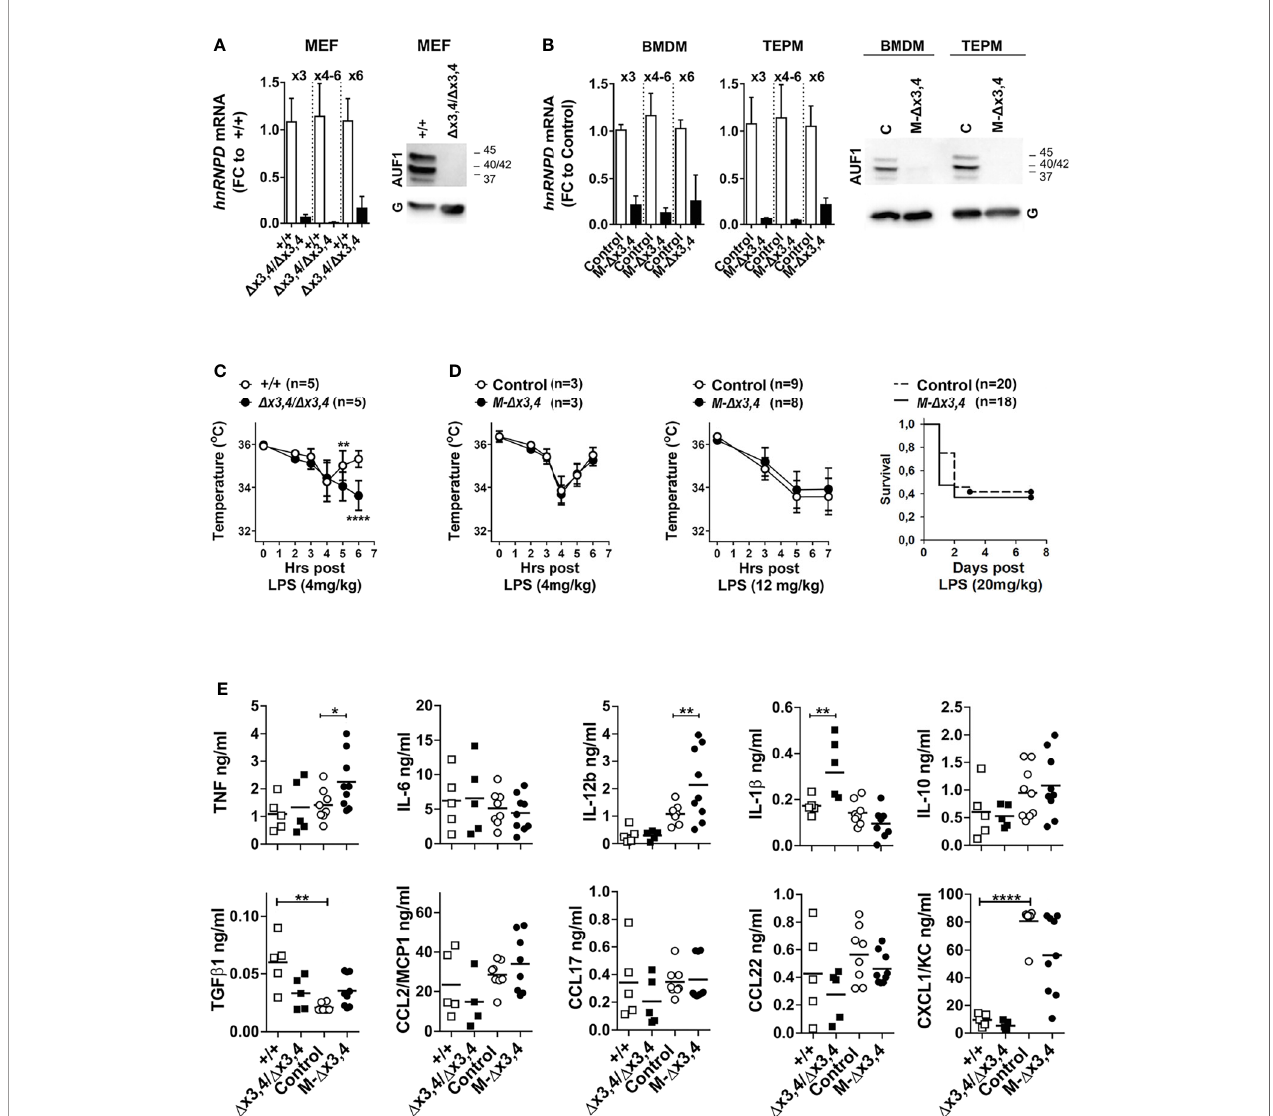
FIGURE 1 | Whole-body and myeloid mutants of AUF1s differ in their responses to endotoxemia. Detection of hnRNPD mRNAs containing exons (x) 3 to 6 via qRT- PCR; and of AUF1 protein isoforms via immunoblots in extracts from (A) hnRNPD +/+ , and hnRNPD D x3,4/ D x3,4 mouse embryonic fi broblasts (MEFs) ; and (B) bone- marrow derived (BMDM) and thioglycolate-elicited peritoneal macrophages from control and LysMCre + hnRNPD fl x3,4/ fl x3,4 (M- D x3,4) mice. Bar graphs show mean fold change values ( ± SD) relative to the corresponding controls. Representative immunoblots indicate signals detected by an anti-AUF1 antibody or GAPDH (G) for quantitation. (C) Body temperature measurements of control and hnRNPD D x3,4/ D x3,4 mice at the indicated time-points post the intraperitoneal administration of the indicated does of LPS. (D) Body temperature and Survival measurements of control and M- D x3,4 mice at the indicated time-points post the intraperitoneal administration of the indicated doses of LPS. Line graphs depict mean temperature values ( ± SD); or Kaplan-Maier percentile cumulative survival. n denotes number of mice per group. (E) Detection of in fl ammatory mediators in the sera from control, whole body (n=5/genotype) and myeloid mutant mice (n=8-9/genotype) 90mins post administration of 4mg/Kg LPS. Scatter plots indicate individual and mean protein values (line) as detected via cytometric bead arrays. For graphs in (A, C – E) (*,**,****) denote p values ≤ 0.05, ≤ 0.01 or 0.00001 respectively as determined via One-Way